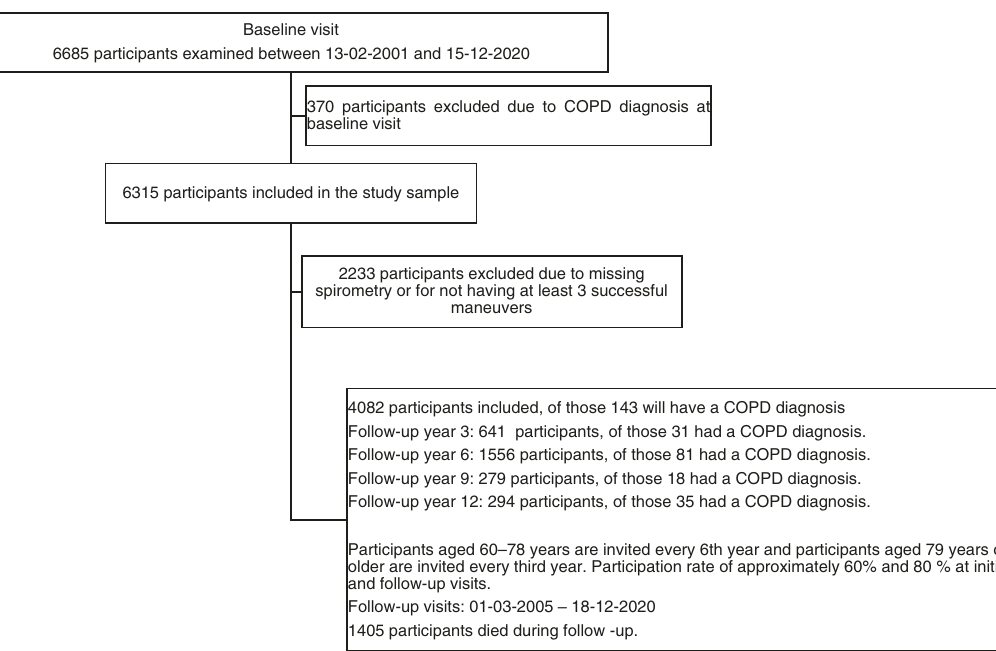
Fig. 1 Study population. Participants diagnosed with COPD, with missing spirometry or unable to perform three successful manoeuvres, at baseline were excluded from this study. During follow-up 143 participants received a COPD diagnosis in clinical